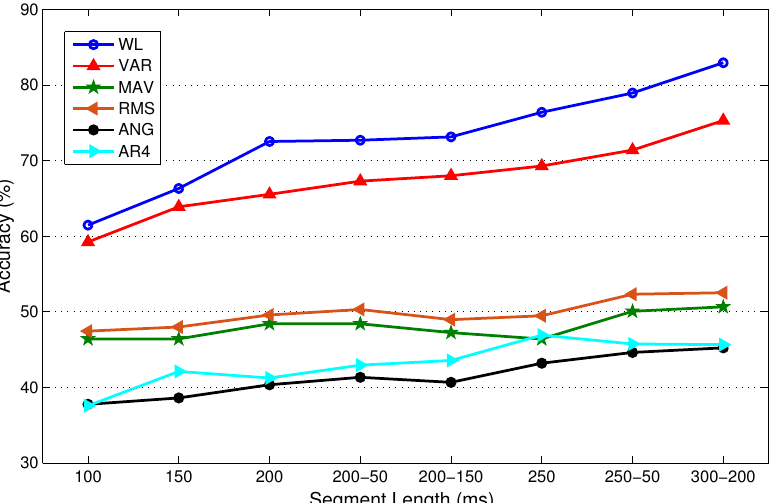
Figure 5. Mean LDA performance for the able-bodied subjects for different data windowing methods and frame lengths. On the horizontal axis, a single value indicates the frame length of disjoint windowing, and a pair of values indicates the frame length and increment length of overlapped windowing. For instance, 200–50 indicates L f = 200 ms and I = 50 ms for overlapped